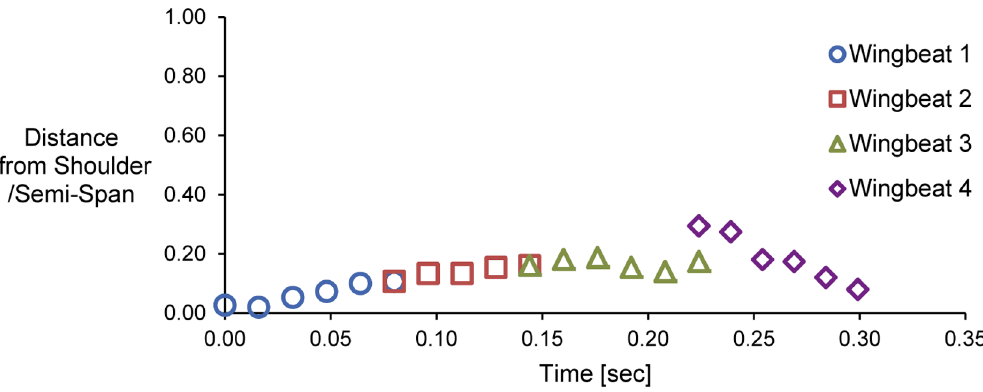
Figure 9. The location of the laser sheet with respect to the right wing during wingbeats 1, 2, 3 and 4.